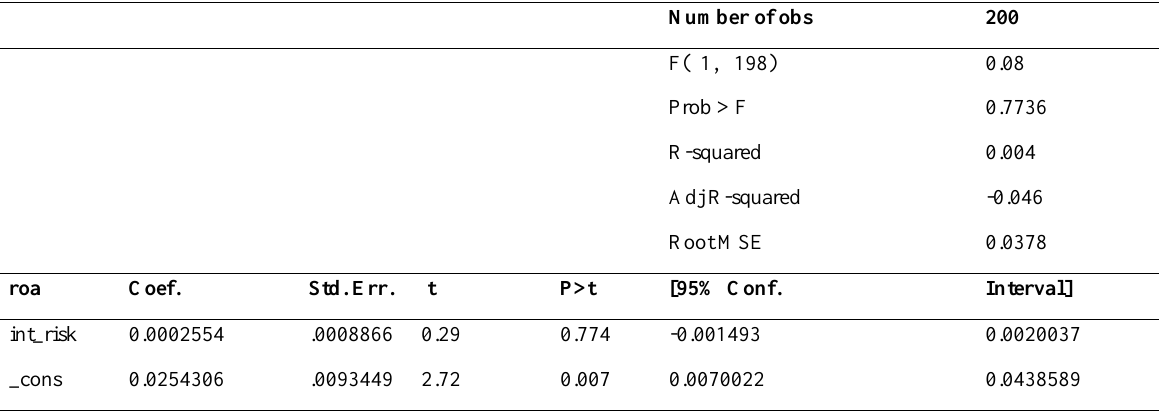
Table 3: Effect of the Interest Rate Risk on Financial